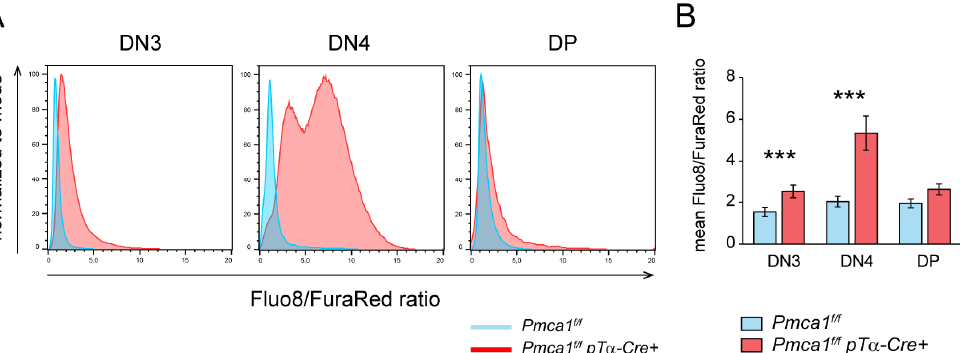
Figure 4. PMCA1 keeps cytosolic Ca 2+ levels low during T cell development. ( A , B ) Flow cytometric ratiometric measurements of basal cytosolic Ca 2+ level in Fluo-8- and FuraRed-labeled thymocytes of Pmca1 f/f and Pmca1 f/f pT α -Cre + mice in a Ca 2+ -containing buffer. The Fluo-8/FuraRed fluorescence intensity ratios in the DN3, DN4 and DP thymocytes, respectively, are shown in the representative histograms ( A ) and were quantified as the mean Fluo-8/FuraRed ratio ± SD acquired over 3 min from 5 experiments ( B ). *** p < 0.001, all by an unpaired two-tailed t -test.